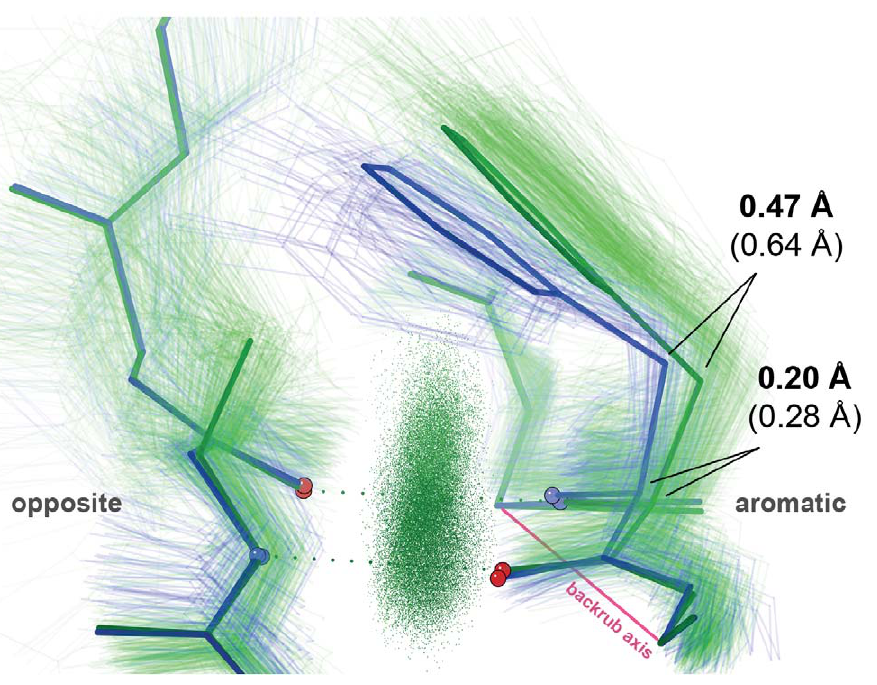
Figure 4. Backrubs at aromatic residues in antiparallel b -sheet. Crystal structure ensembles for Phe/Tyr across from Gly (light blue) vs. anything else (light green) are related by a backrub. Lowest-energy BRDEE conformations for 1z84 Phe171 across from Gln188 (visually truncated at C b for clarity) (dark green) vs. Gln188 R Gly (dark blue) have a similar relationship. Aromatic C a and C b displacements for both average crystal structures (lighter, in parentheses) and low-energy BRDEE conformations (darker) evoke a hinge-like backrub operation. Ensemble mainchain-